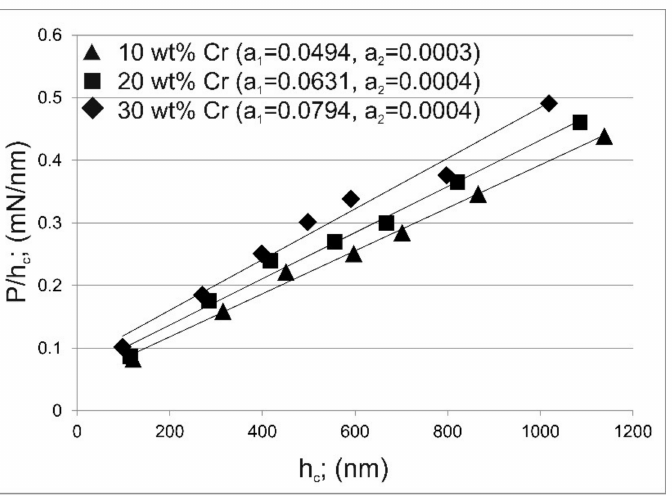
Figure 9. Dependence of the P on the contact depth of the indenter with the sample at maximum h c indentation load h c according to Li and Bradt model for the tested areas containing 10, 20 and 30 wt.% of